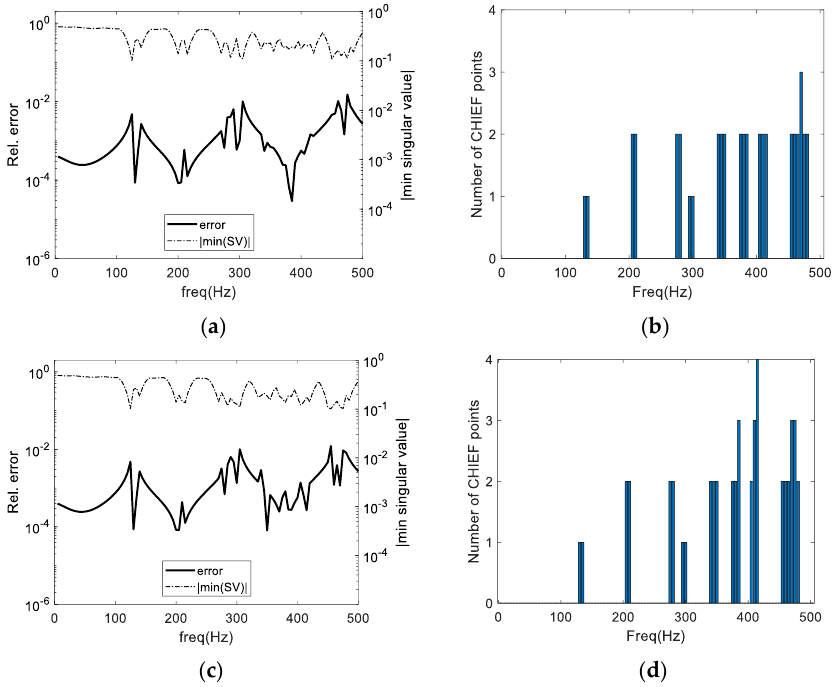
Figure 8. Results computed using the proposed algorithms: ( a , c ) show the relative error and smallest singular value and ( b , d ) show the number of CHIEF points used at each frequency. ( a , b ) refer to algorithm ALG1, and ( c , d ) to algorithm ALG2.